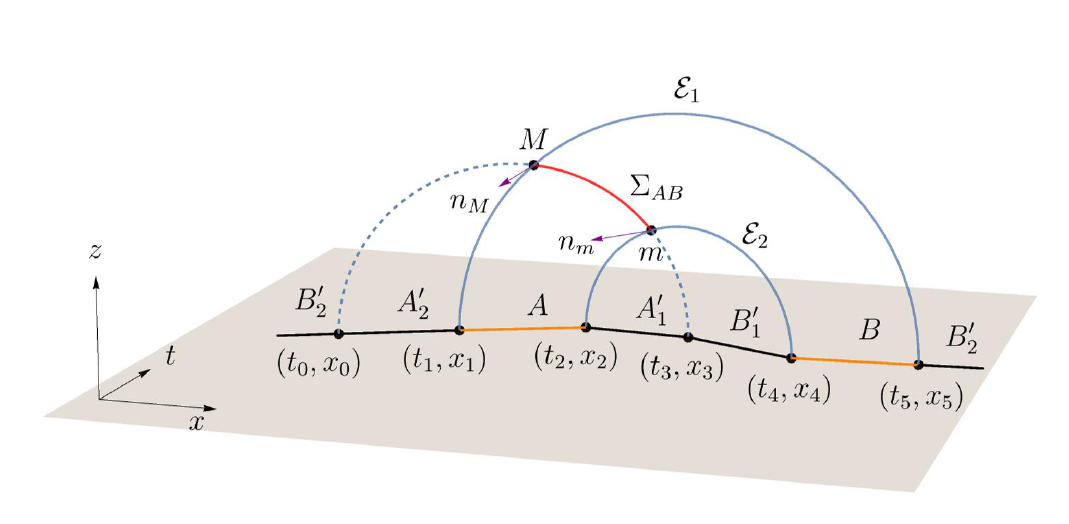
) and , x 0 0 are M , m